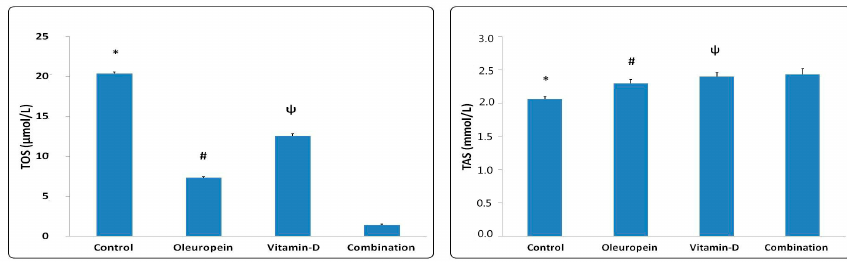
Figure 1. Annexin V and Caspase 3/7analysis results. * Oleuropein treatment has significantly increased early apoptosis as compared to other groups ( p < 0.05). # Combination treatment has significantly increased late apoptosis as compared to other groups ( p < 0.05). Ψ Combination treatment has significantly increased total apoptosis (early + late) as compared to other groups ( p <